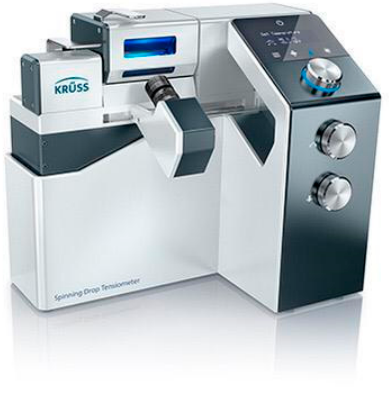
Figure 2. Spinning drop tensiometer. Viscosities at different shear rates and temperatures were routinely monitored, and the data obtained when the temperature was stable. Tables 2 and 3 present the rheological properties of the APG 264, XG, acetone, and butanone. Table 2. Observed and Measure Data for Acetone (0.6%), APG (0.5%), and Xanthan Gum at Various Temperatures.